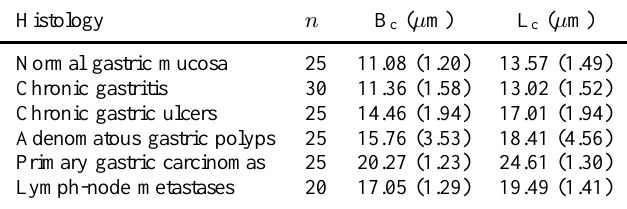
Table 3 Cellular morphometry: B c and L c are, respectively, the minor and major caliper diameters of the cellular profiles. Means and standard deviations are for n patients. For each patient, the parameter